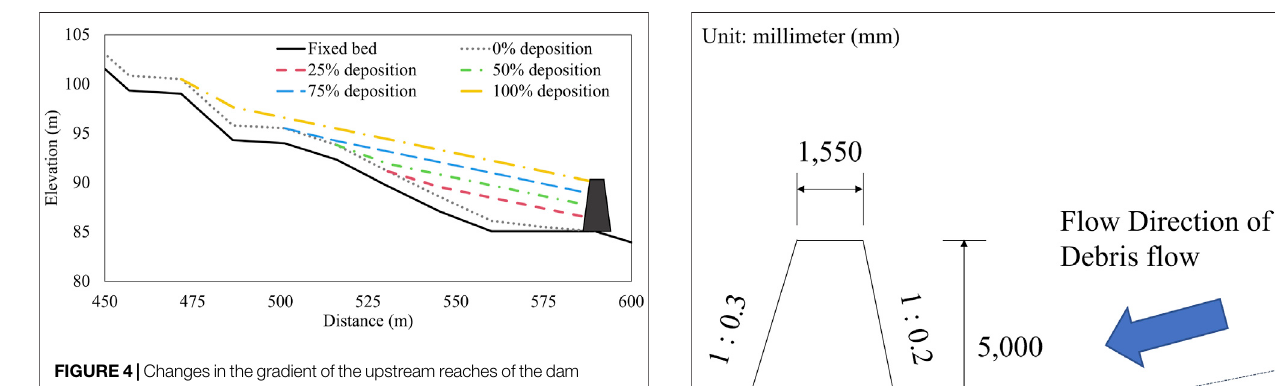
Frontiers in Earth Science |